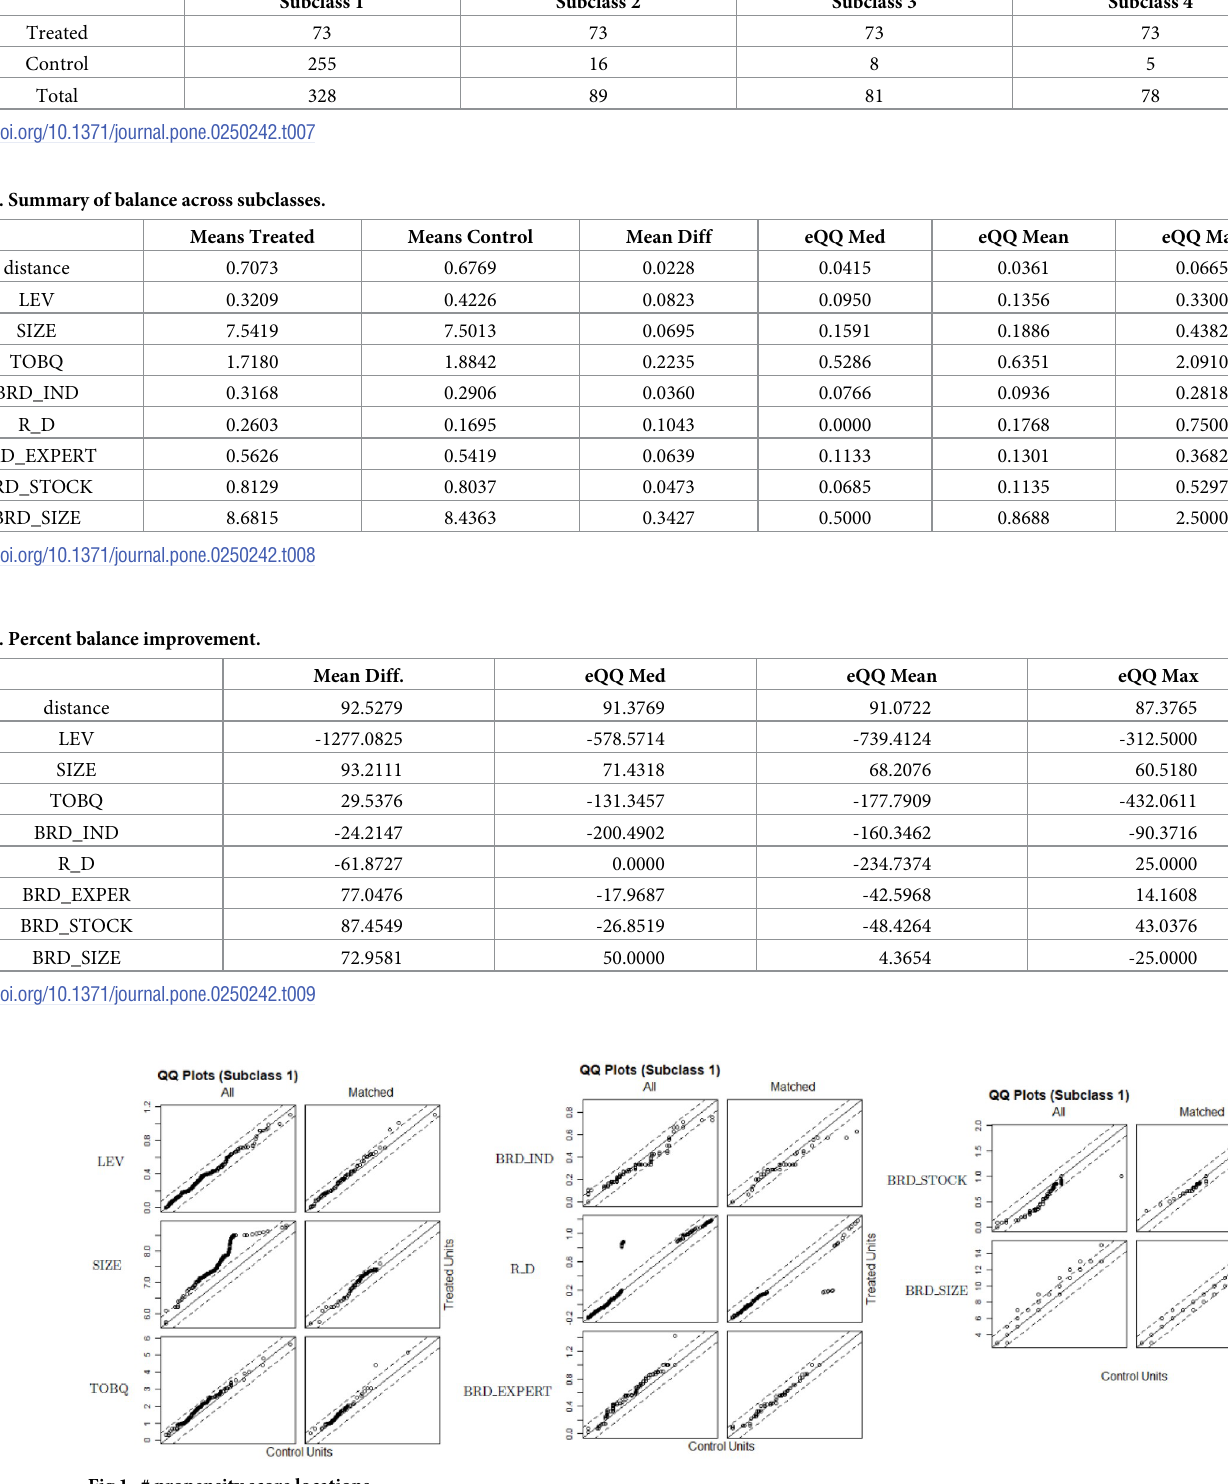
Fig 1. # propensity score